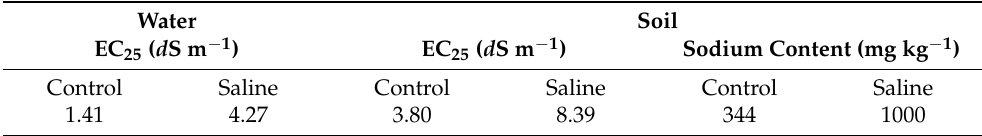
Table 1. The soil and water characteristics under control and saline conditions. EC 25 is the electrical conductivity, which calculated to 25 ◦ C from water and water/soil extracts in d S m − 1